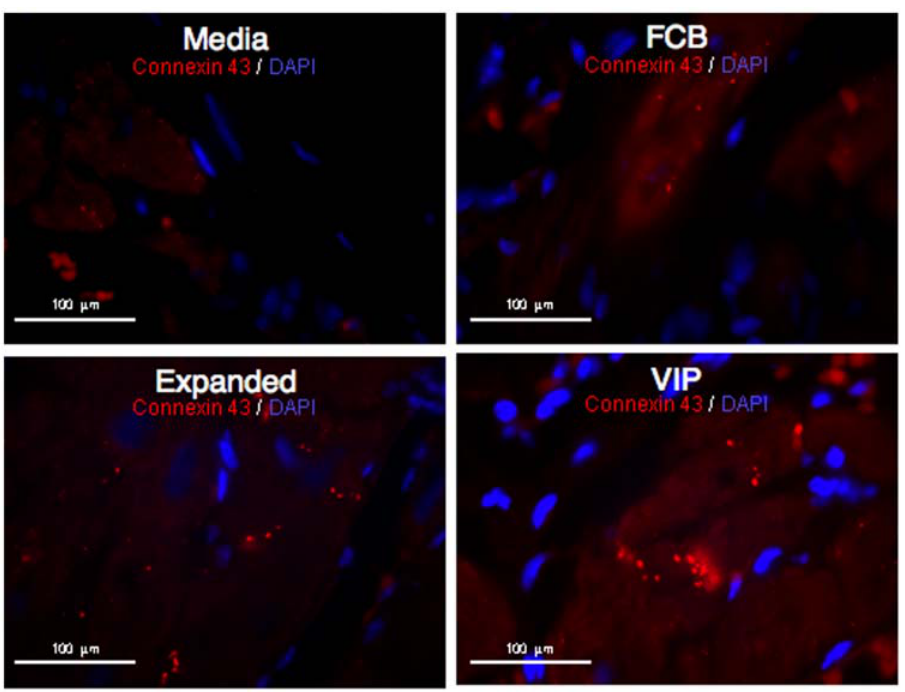
Figure 6. Expression of gap junctional protein, connexin 43. Heart tissue sections were stained for gap junctional protein, connexin 43 from all four groups using immunohistochemistry. Red color indicates connexin 43 stain and blue color indicates DAPI, a nuclear stain. Merged connexin 43 and DAPI of each group is displayed in micrographs.